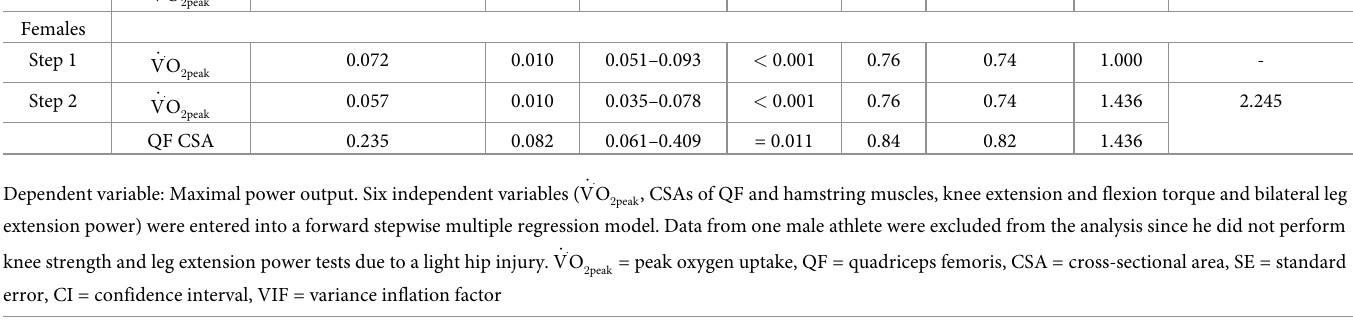
multiple regression model (Table 3). In female athletes, there were significant correlations (r = 0.87, p < 0.001, Fig 3A), the CSA of QF (r = 0.72, p = 0.001, between MPO and _ VO 2 peak Fig 3B) and the CSA of hamstrings (r = 0.54, p = 0.018, Fig 3C). The multiple regression model revealed that MPO was attributed to, in the order of importance, _ VO and the CSA of QF 2 peak (Table 3). In both male and female athletes, significant correlations were not found between MPO and the parameters of lower extremity strength or power (Fig 3D–3F). Regression equa- tions for male and female athletes obtained from the stepwise multiple regression analysis were as follows: